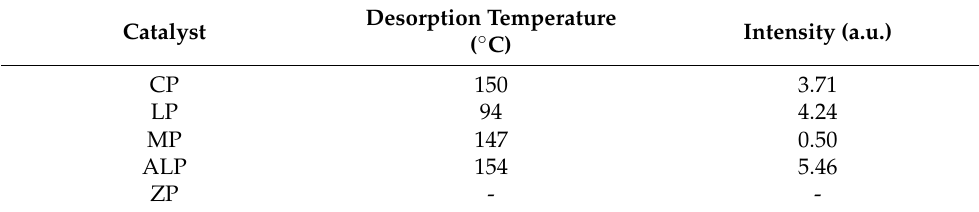
Figure 6. CO 2 -TPD curves of different metal phosphate catalysts. Table 3. CO 2 -TPD results of different metal phosphate catalysts.